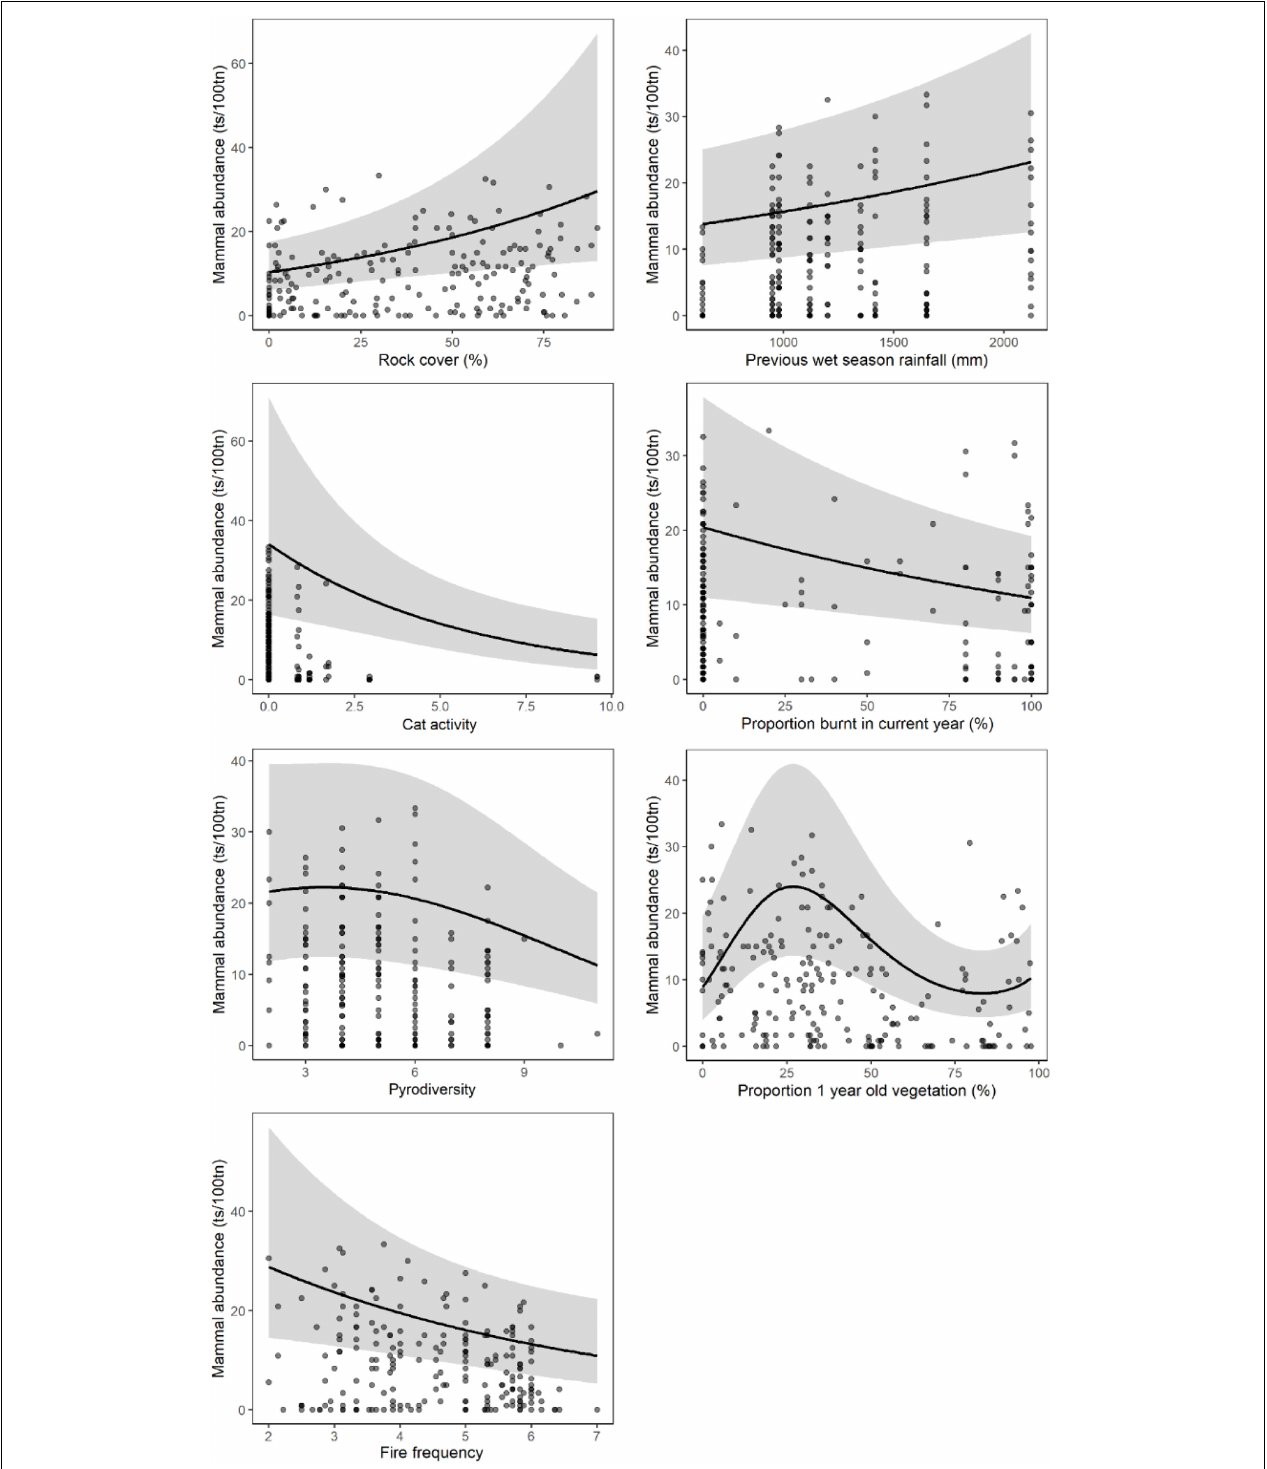
FIGURE 3 | Mammal abundance [trap success per 100 trap nights (ts/100 tn)] in sandstone habitat shown only for highly influential predictor variables sampled at the 3 km scale around each site (see Table 2 ). Relationships for each variable were derived from GLMM predictions while holding other explanatory variables constant at their median level. Model fit is shown by a black line and the gray band represents the 95% confidence interval. Gray circles indicate observed data values and are darker when repeated observations occur at the same point. Cat activity is cat detections per 100 camera trap nights, pyrodiversity is the number of post fire vegetation ages within 3 km of the site, fire frequency is the number of times the site was burnt in the previous 10 years.